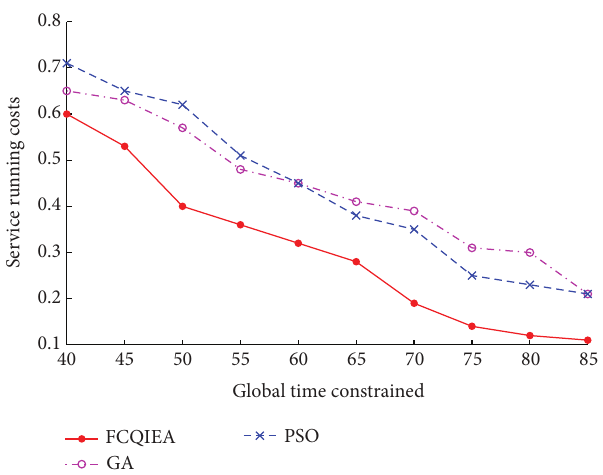
Figure 8: The probability of success of different service allocation strategy.